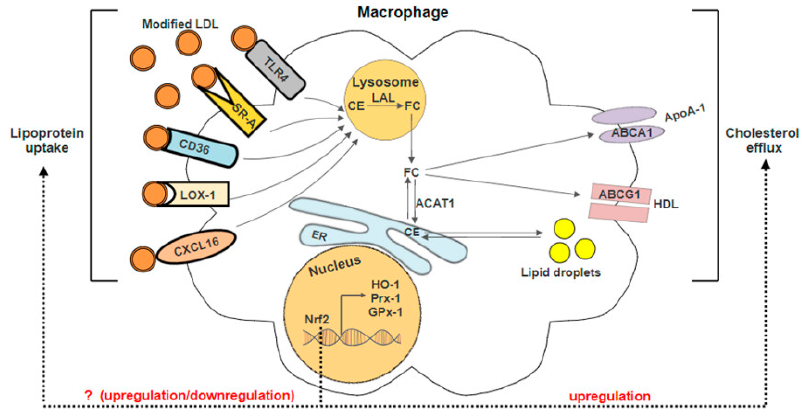
Figure 3. Mechanism of Nrf2 in regulating macrophage lipoprotein uptake and cholesterol efflux. Macrophages internalize modified LDL via scavenger receptors such as scavenger receptor class A (SR-A), scavenger receptor class B (CD36), lectin-type oxidized LDL receptor 1 (LOX-1), toll-like receptor 4 (TLR4) and chemokine (C-X-C motif) ligand 16 (CXCL16). The internalized modified LDL is trafficked to the lysosomes where lysosomal acid lipase (LAL) hydrolyses the excess free cholesteryl esters (CEs) to free cholesterol (FC). FC can be effluxed from the cell via ATP-binding cassette (ABC) transporters, including ABCA1 and ABCG1 or to the endoplasmic reticulum (ER). ABCA1 and ABCG1 mediate lipid efflux to lipid-free apoA-1 and HDL, respectively. In ER, the FC is re-esterified to CE by enzyme acyl-CoA: cholesterol acyltransferase (ACAT1) and stored as cytoplasmic lipid droplets. The accumulation of lipid droplets triggers the foam cells formation, which results in activation of Nrf2 and its-regulated antioxidant proteins including heme oxygenase 1 (HO-1), peroxiredoxins (Prxs), and glutathione peroxidase 1 (GPx1). Under atherogenic conditions, Nrf2 activation may up-regulate or down-regulate the expression of the lipoprotein uptake receptors. In reverse cholesterol transport, activation of Nrf2 promotes the cholesterol efflux by up-regulating the ABC transporter proteins expression. ApoA-1 indicates apolipoprotein A-1 and HDL, high-density